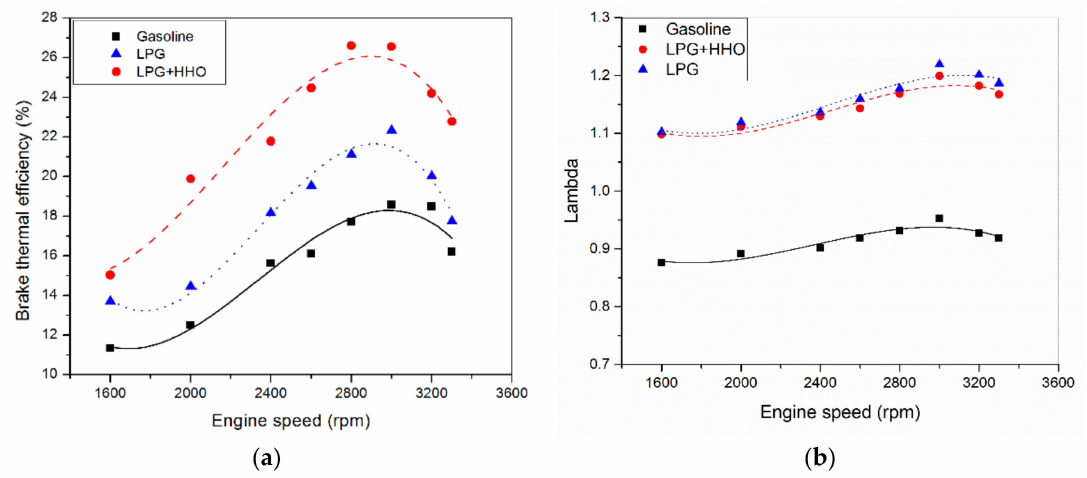
Figure 4. ( a , b ) Comparisons of brake thermal e ffi ciency and lambda for gasoline, LPG and LPG-HHO